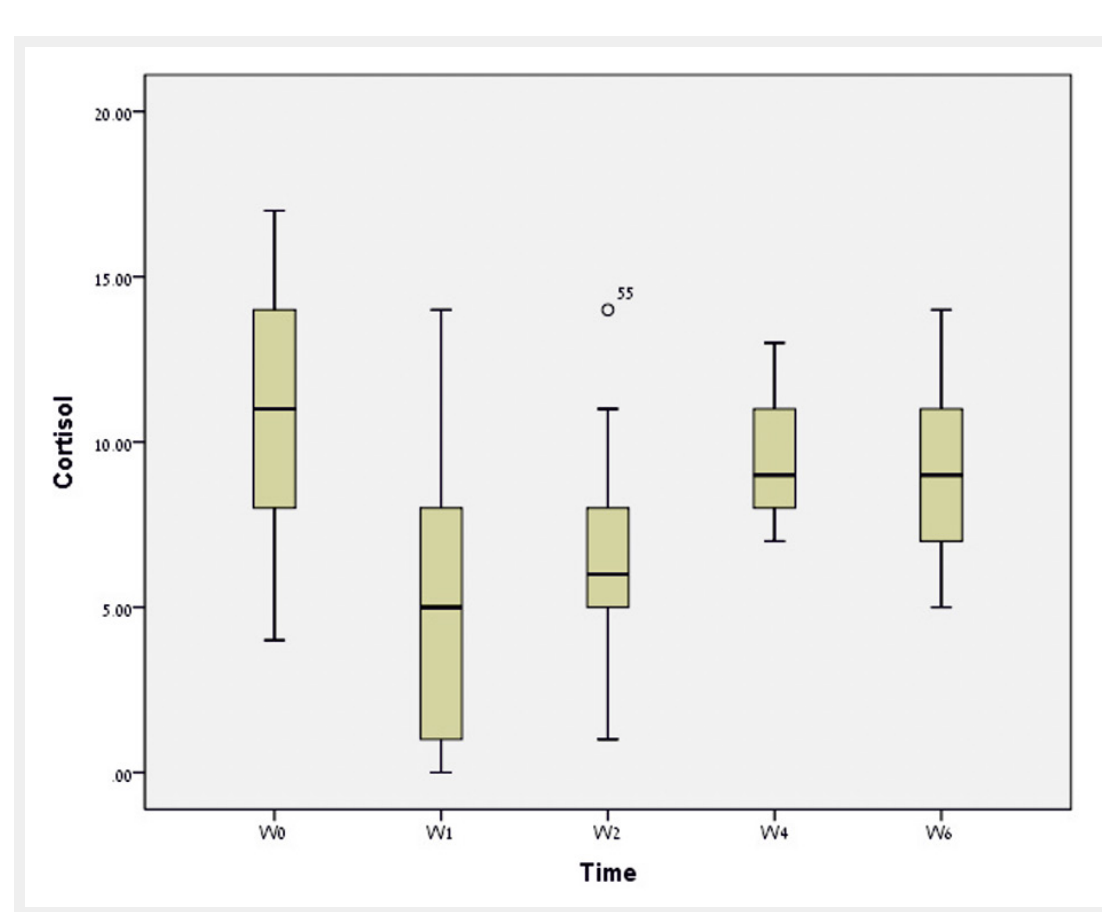
Basal serum cortisol levels at baseline and at different time points in all the patients. Box plot showing distribution of serum cortisol levels at each time-point, where the lower and upper borders of the box and the line inside it represent quartile 1 (Q1), Q3 and the median values, and the upper and lower whiskers represent Q3+ 1.5 interquartile range (IQR) and Q1-1.5 IQR, respectively. The numbered circle represents the serial number of the patient had a cortisol level higher than the upper whisker. W0 = baseline; W1 = week 1; W2 = week 2; W4 = week 4; W6 = week